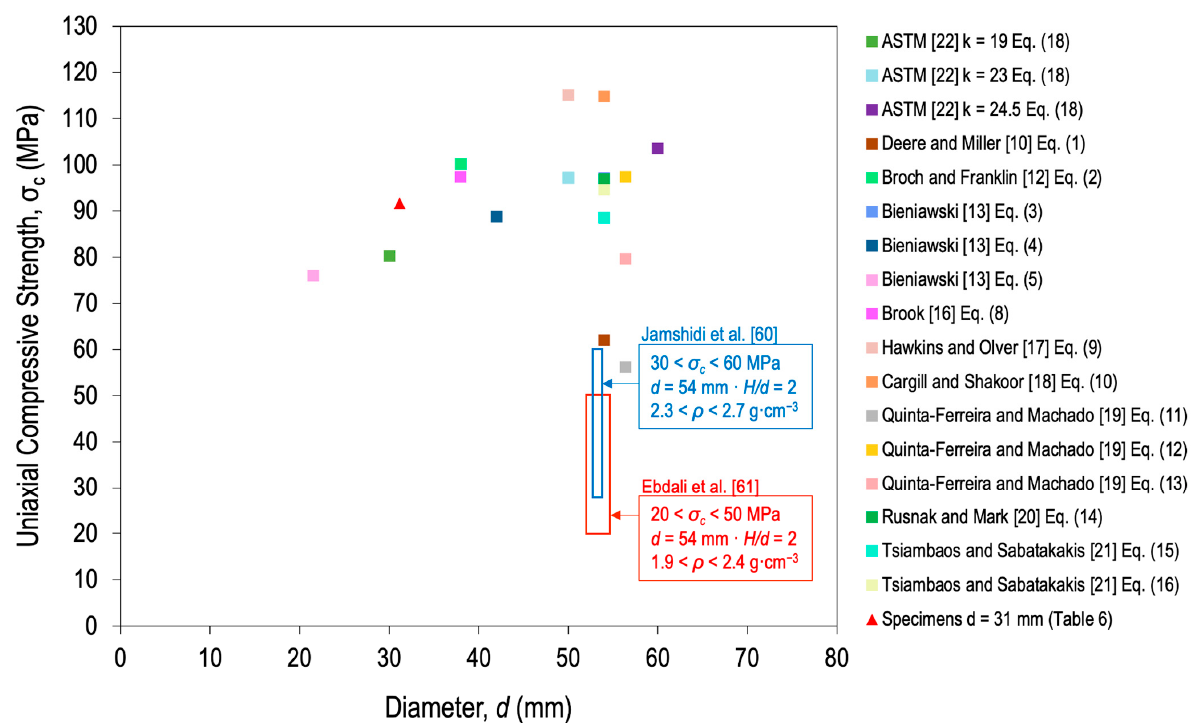
Figure 9. Estimation of σ c from the correlations with I s , I s (50) , and I s (50) of Table 1 for travertine.